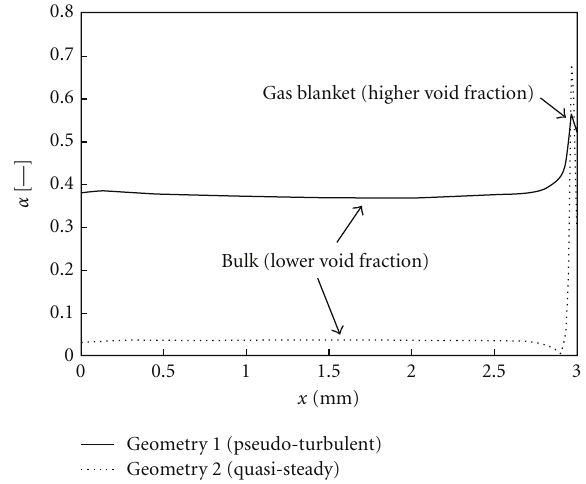
Figure 3: Comparison between the time averaged void fraction profile at the center of Geometry 1 (pseudo-turbulent regime, con- tinuous line) and at in the center of the central channel (C2S2) of Geometry 2 (quasi-steady regime, dotted line).